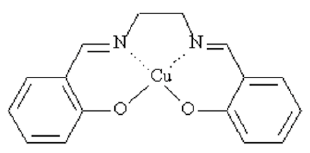
Figure 8. Monomer [Cu(Salen)].